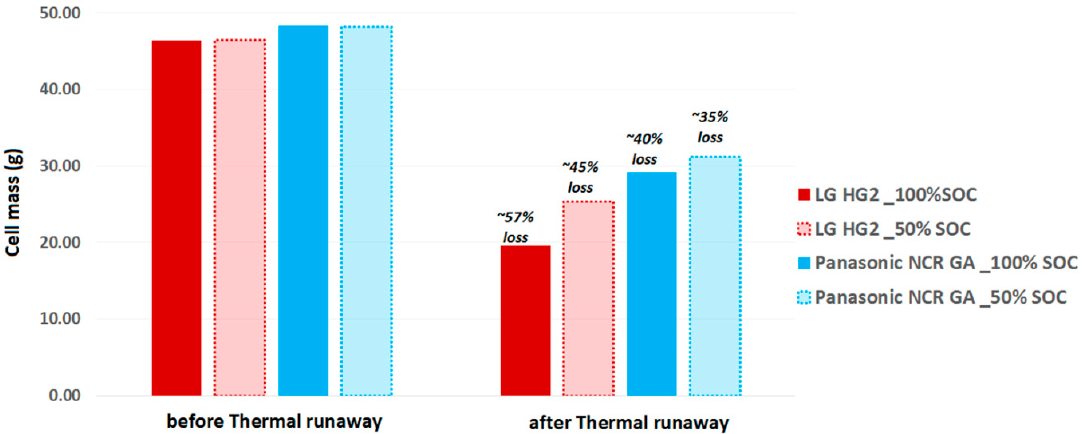
Figure 15. Cell mass before and after thermal runaway.